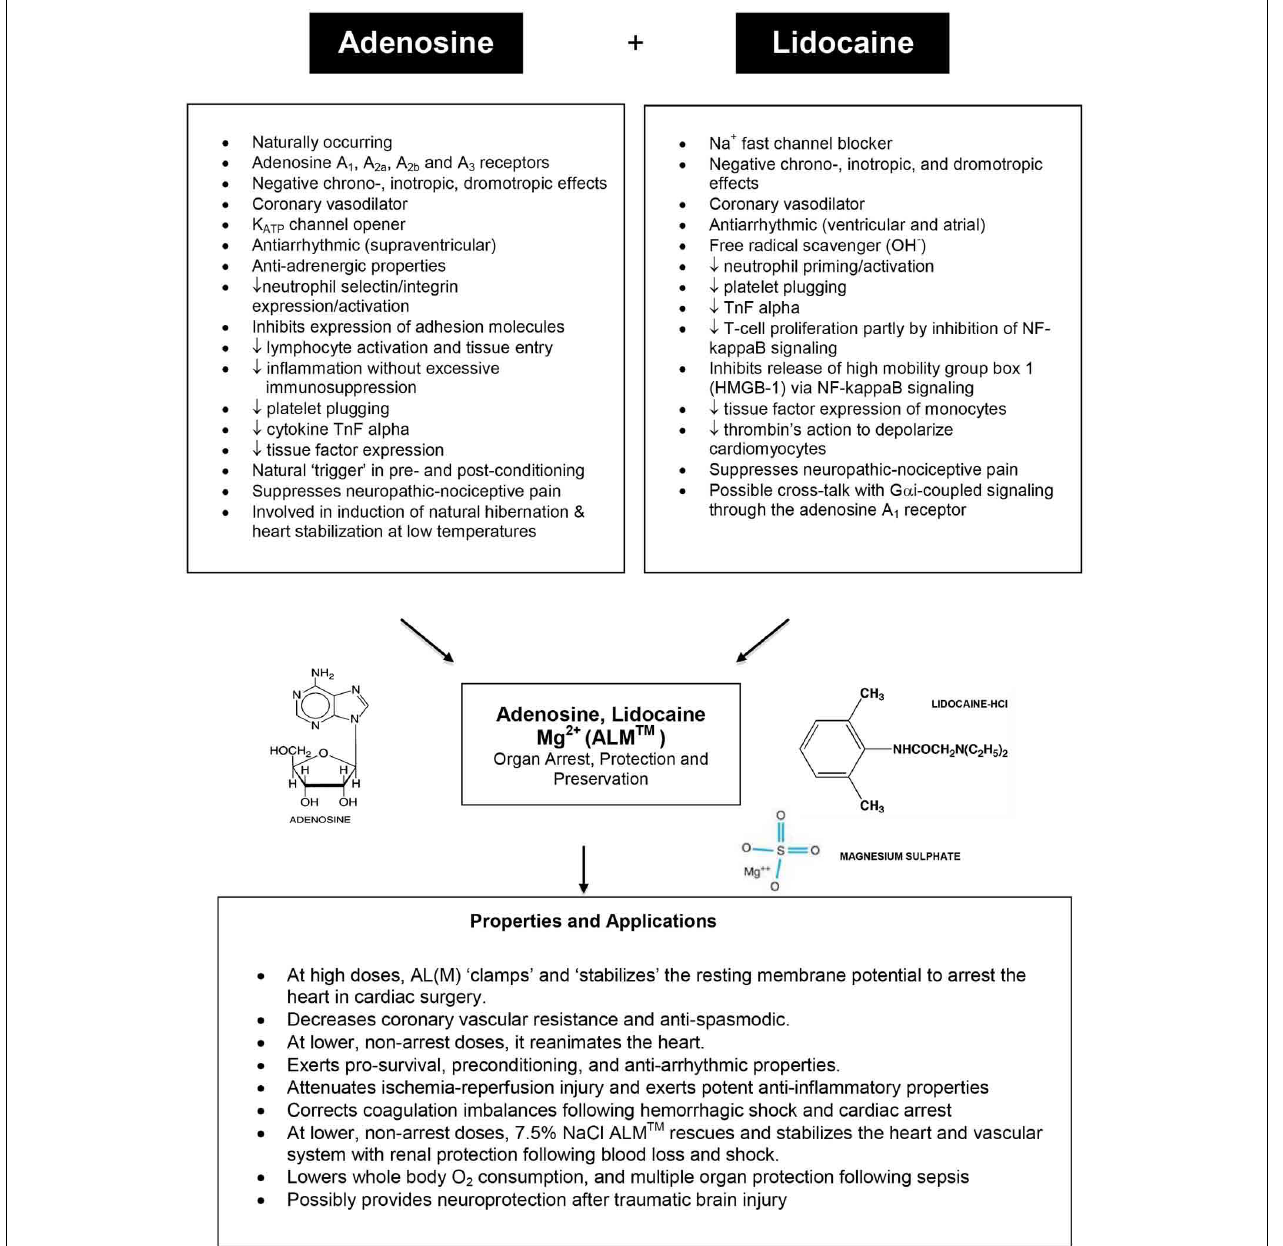
FIGURE 7 | Summary of the major properties and structures of adenosine and lidocaine (with Mg 2 + ), and their potential mechanisms of action for heart arrest, protection and preservation (see text for details).